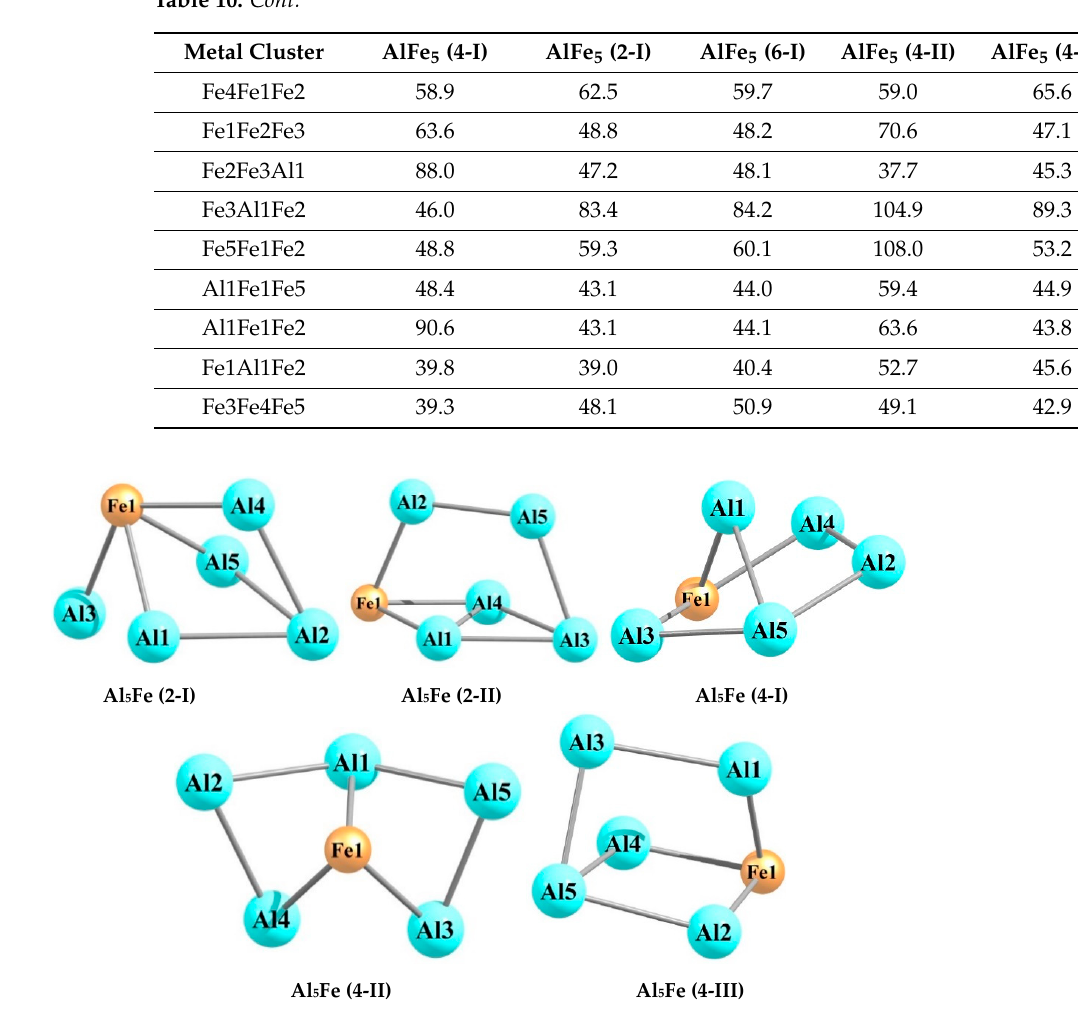
Figure 1. Molecular structures of the five most energetically stable Al 5 Fe metal clusters. Table 2. Key structural parameters of the most stable Al 5 Fe metal clusters.